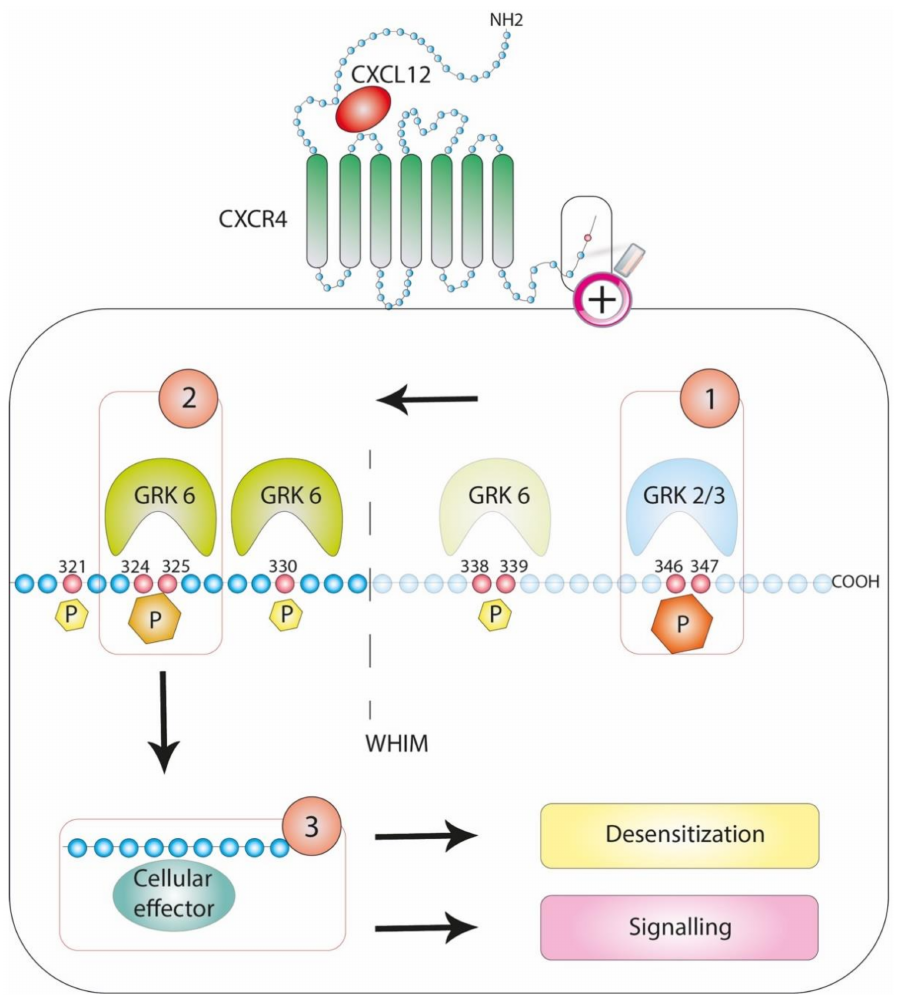
Figure 2. Hierarchical phosphorylation pattern at the C-ter of CXCR4. Upon CXCL12 binding to CXCR4, a cascade of phosphorylation takes place at the C-ter of the receptor following a hierar- chical order, as depicted by the numbering. Subsequently, cellular effectors (e.g., arrestins and the COMMD3/8 complex) are recruited and promote signalling and receptor desensitization. The ab- sence of the dominant 346/347 phosphosites in Warts, Hypogammaglobulinemia, recurrent bacterial Infections and pathognomonic Myelokathexis (WHIM)-associated CXCR4 C-ter truncation prevents CXCR4 desensitization. The most common C-ter truncation occurring in WHIM patients is depicted by a dashed line and faded